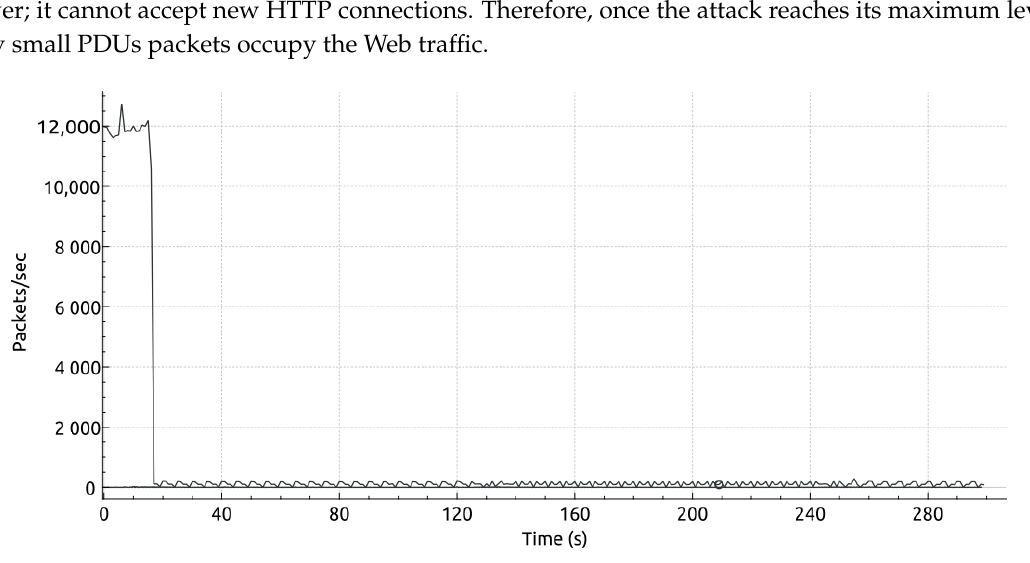
Figure 1. Web server traffic during a Slowloris